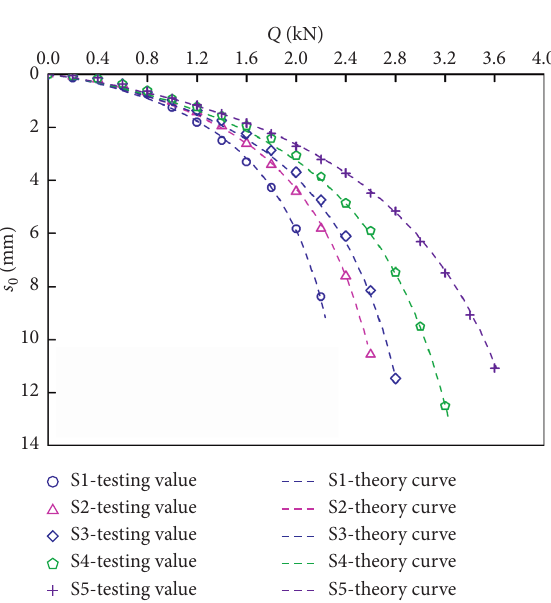
Figure 8: Comparison of Q - s curves between testing value and theory result.